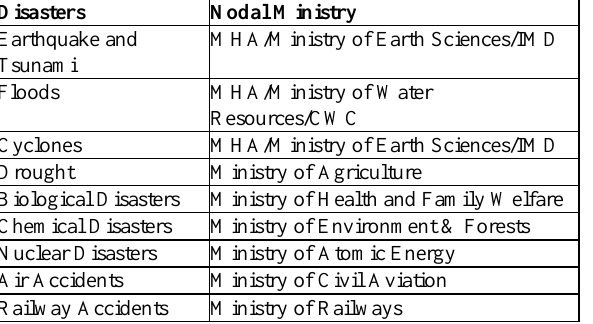
Table 2: S & T ministries of India and focus on specific disaster